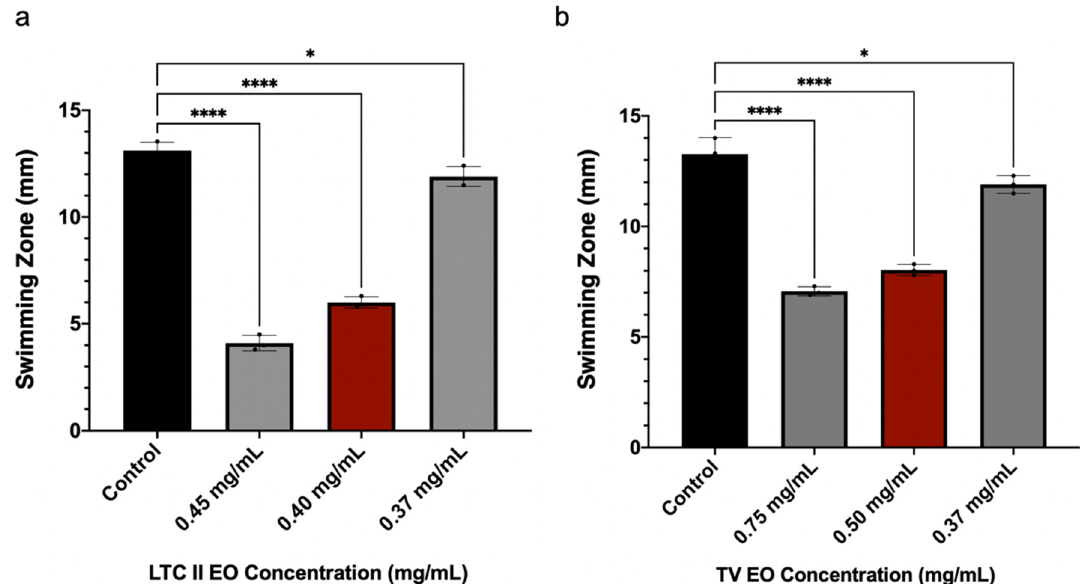
Figure 5. Effect of subinhibitory concentrations of the EOs of ( a ) LTC II and ( b ) TV on the swimming motility of E. coli ATCC 25922. Cultures were incubated for 24 h using semi-solid LB medium at 37 °C. The percentage inhibition was calculated by measuring the growth halo in mm, considering the swimming produced by the control culture (untreated). All experiments were performed in triplicate and analyzed by one-way ANOVA. **** p ≤ 0.0001, * p ≤ 0.0158.